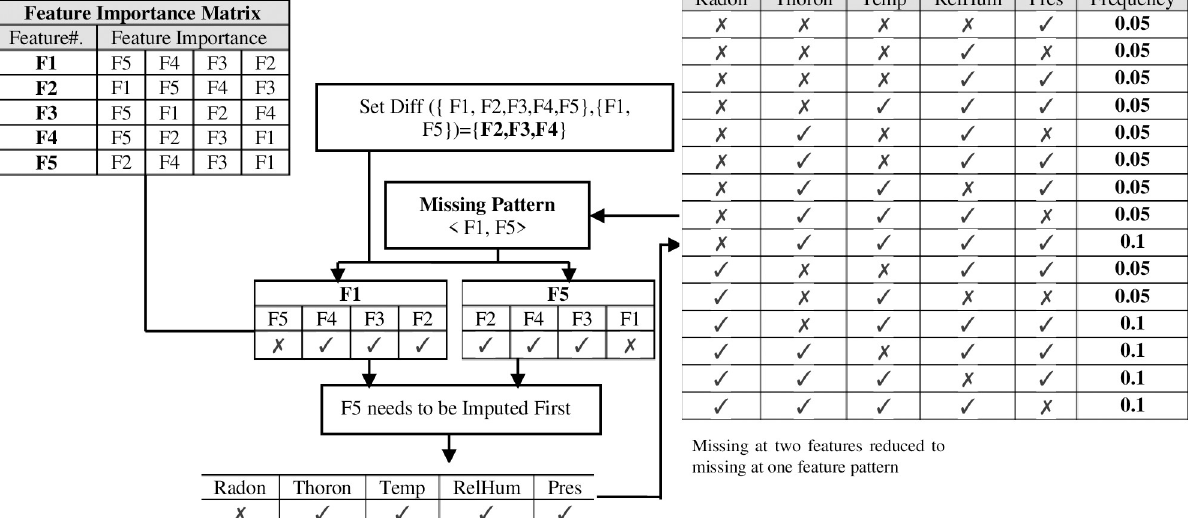
PLOS ONE | https://doi.org/10.1371/journal.pone.0262131 January 13,